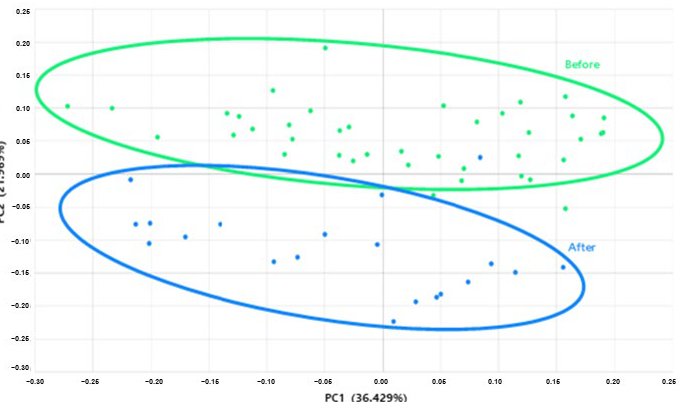
Figure 3. Multivariate statistical analysis of before/after clinical trial of shampoo containing of Cicaria supernant .